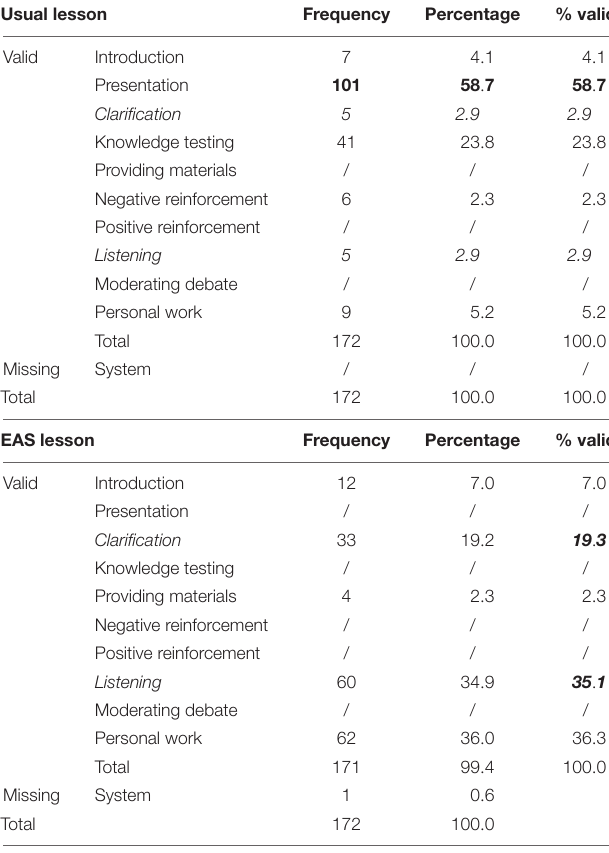
TABLE 4 | Differences in class management between usual lessons and EAS lessons.